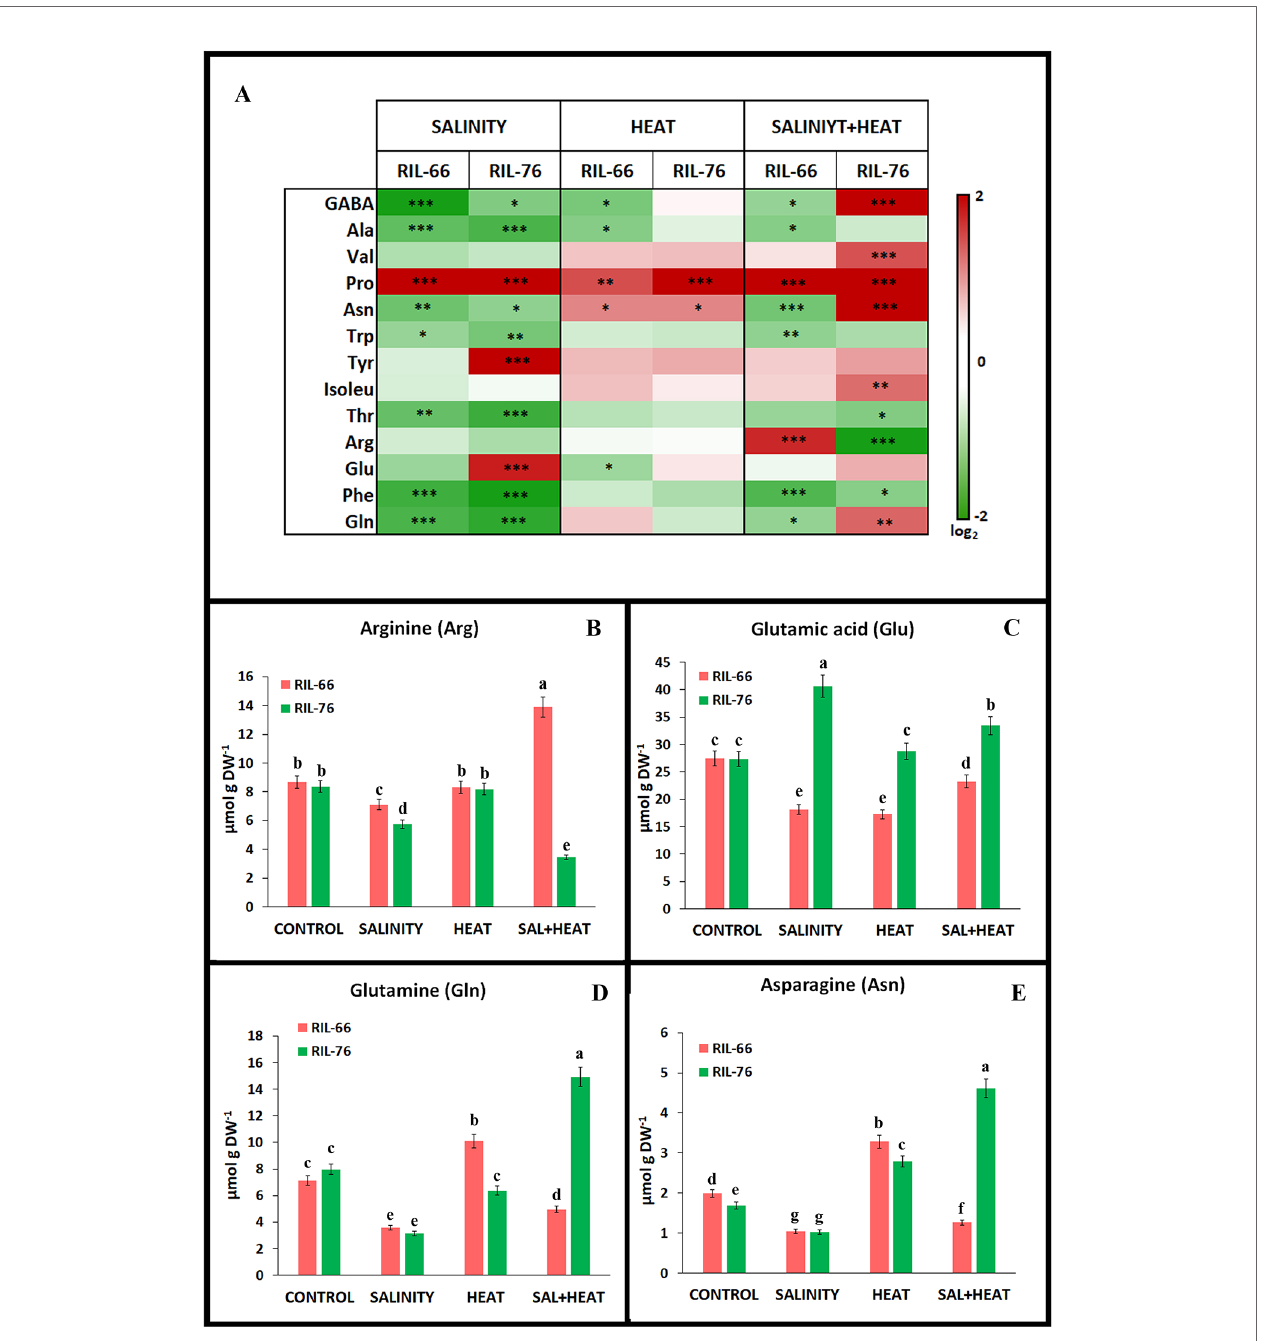
FIGURE 5 | Amino acids concentration in leaves of tomato recombinant inbred line (RIL)-66 and RIL-76 under salinity, heat, or the combination of salinity and heat. (A) Heat map of the amino acid concentration (expressed as log 2 ) in tomato leaves of RIL-66 (salinity + heat sensitive) and RIL-76 (salinity + heat tolerant) under salinity heat and the combination of salinity+heat. Stars are representative of signi fi cant differences p < 0.05 (*p < 0.05, **p < 0.01, ***p < 0.001) respect to control plants. (B – E) Absolute concentration of the main amino acids related to nitrogen assimilation pathway. Bars are mean values ± SE (n = 6), and bars with different letters are signi fi cantly different at p < 0.05 according to Tukey's test. (n =